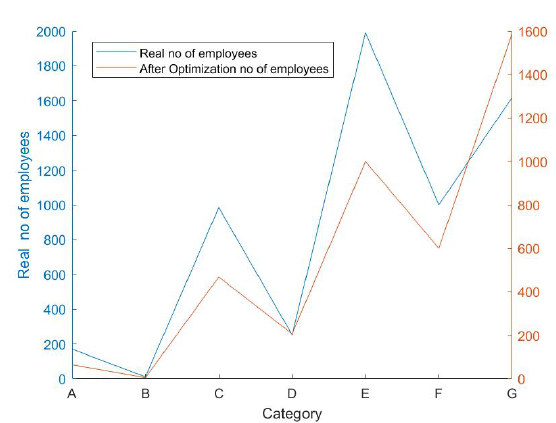
Figure 16. Number of employees in each category.